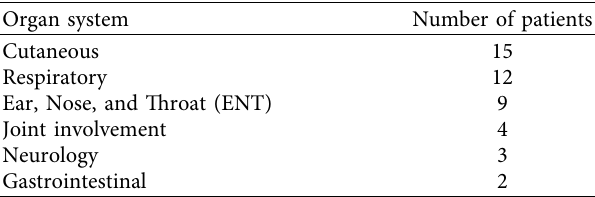
Table 2: Other organ systems